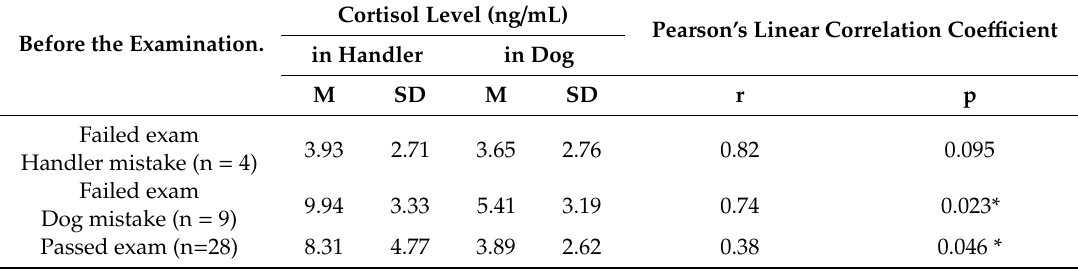
Table 6. Comparison of cortisol levels in handlers and dogs before the exam depending on the result of the exam and the cause of